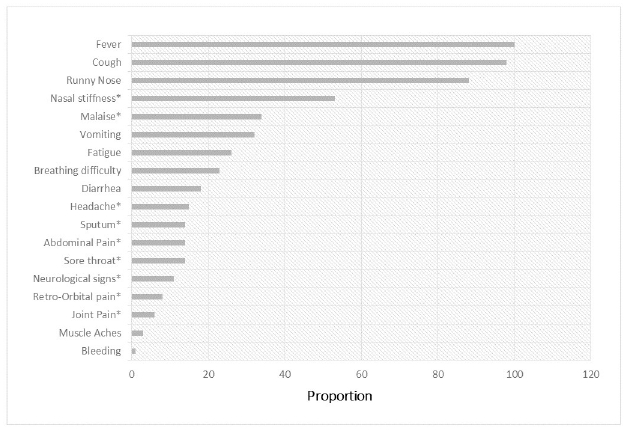
Fig 2. Clinical characteristics of the study participants with influenza-like illness (ILI). � Missing values >